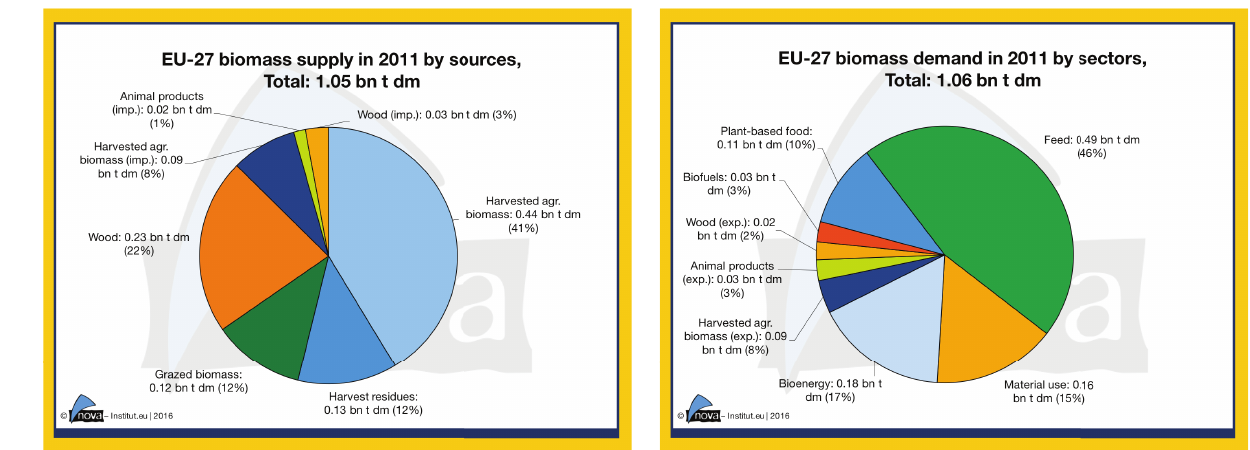
Figure 3: Biomass supply of the EU-27, 2011, by biomass sources Source Food and Agriculture Organization Corporate Statistical Database (FAOSTAT). Statistical database of the FAO. 2014. Available at http://faostat.fao.org/site/ 339/default.aspx (Last accessed March 2015).